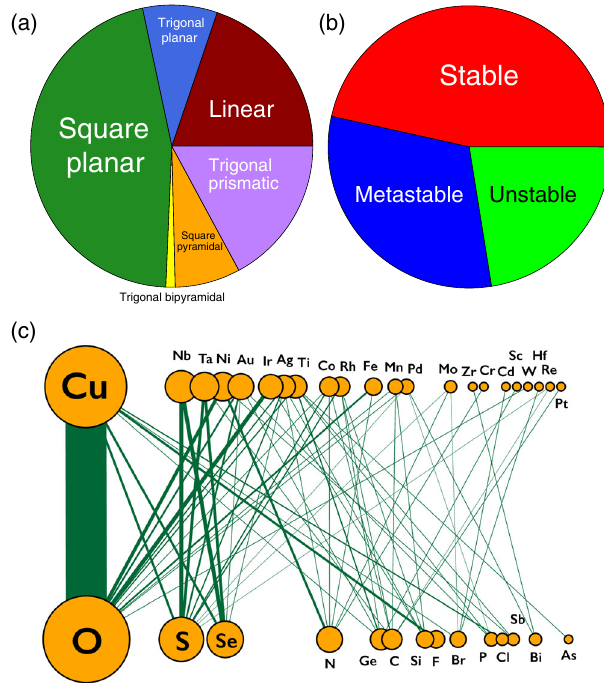
FIG. 2. Characterization of the identified compounds. Distri- bution of the 187 candidate compounds in terms of (a) TM coordination geometry, (b) thermodynamic stability, and (c) iden- tity of the TM and its nearest-neighbor